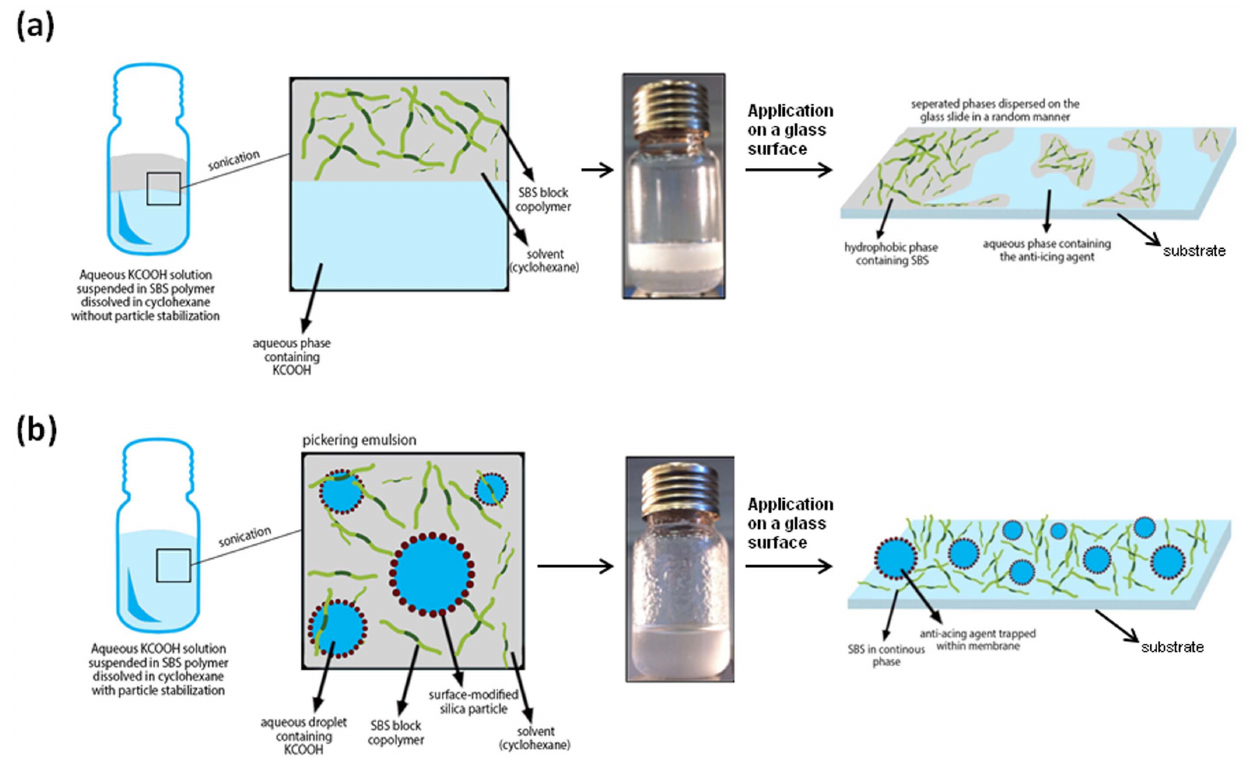
Figure 1. Schematic representation of the steps for casting of solutions prepared with aqueous KCOOH solution suspended in SBS polymer (a) without particle stabilization, or (b) with particle stabilization.